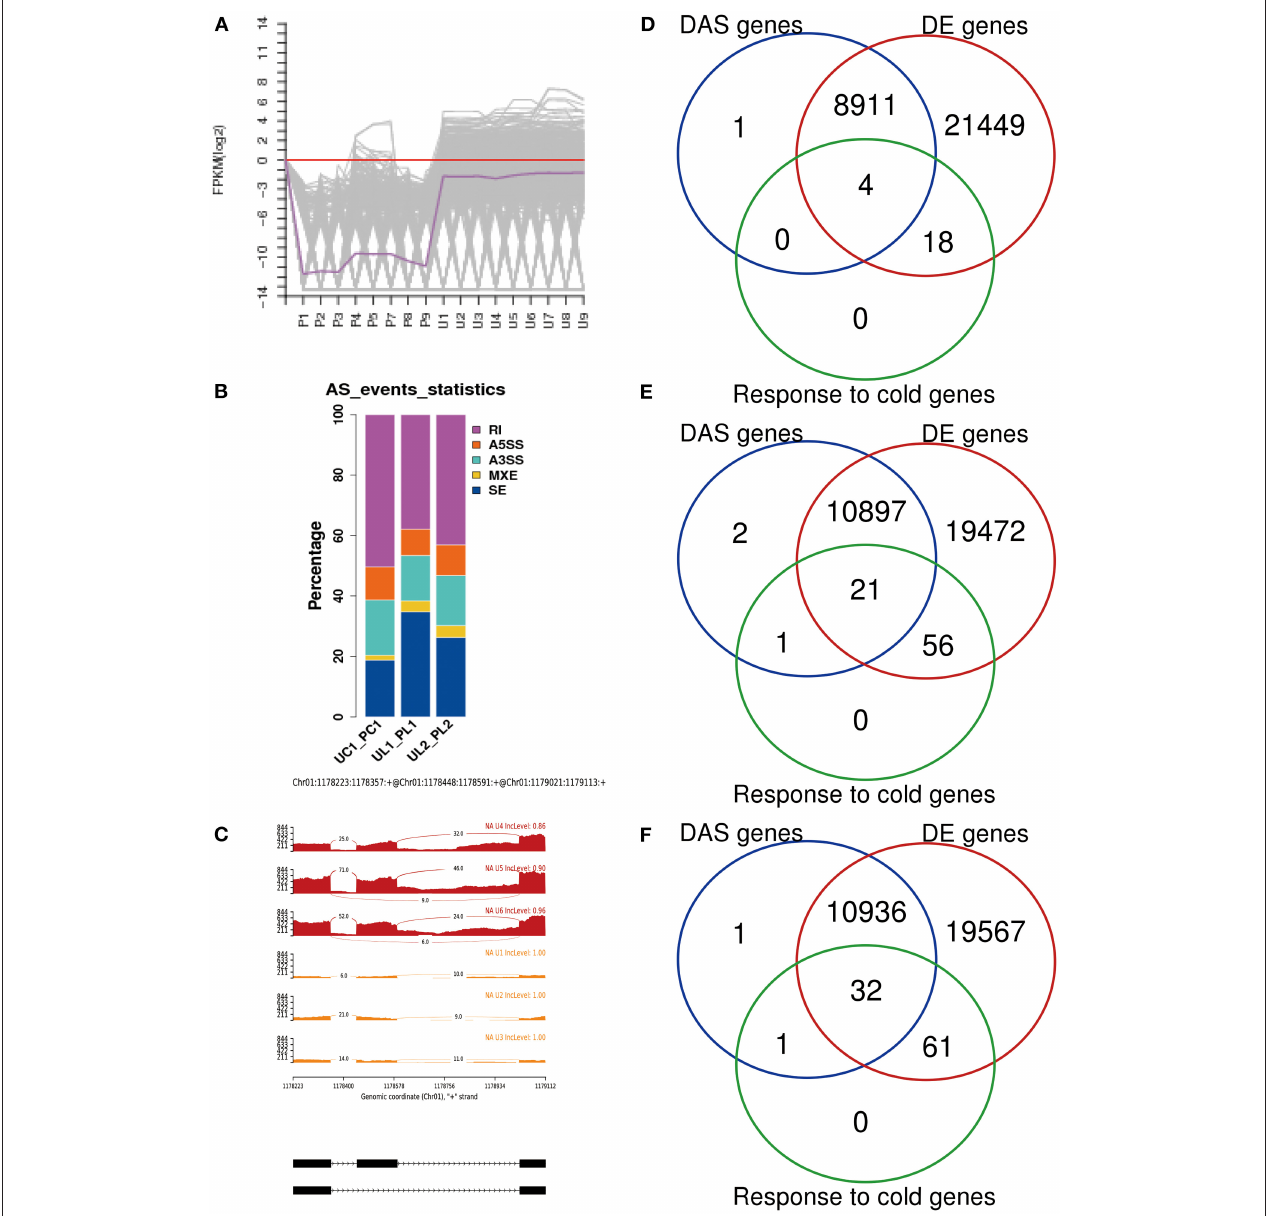
FIGURE 7 | Changes in DEGs and DAS genes in response to cold stress. (A) One subclass of differentially expressed genes (DEGs) clustering in P. ussuriensis compared with P. trichocarpa in response to cold stress identified by RNA sequencing analysis. (B) AS events analysis between P. trichocarpa and P. ussuriensis UC1_PC1: AS percentage statistical analysis at 25 ◦ C in P. trichocarpa compared with P. ussuriensis ; UL1_PL1: AS percentage statistical analysis at 3 ◦ C in P. trichocarpa compared with P. ussuriensis ; UL2_PL2: AS percentage statistical analysis at − 3 ◦ C in P. trichocarpa compared with P. ussuriensis. (C) A model pattern example from the IGV view of Potri.001G016200 alternative splicing (ES) type. (D) The Venn view of DAS genes, DE genes, and genes response to cold at 25 ◦ C. (E) The Venn view of DAS genes, DE genes, and genes response to cold at 3 ◦ C. (F) The Venn view of DAS genes, DE genes, and genes response to cold at − 3 ◦ C.